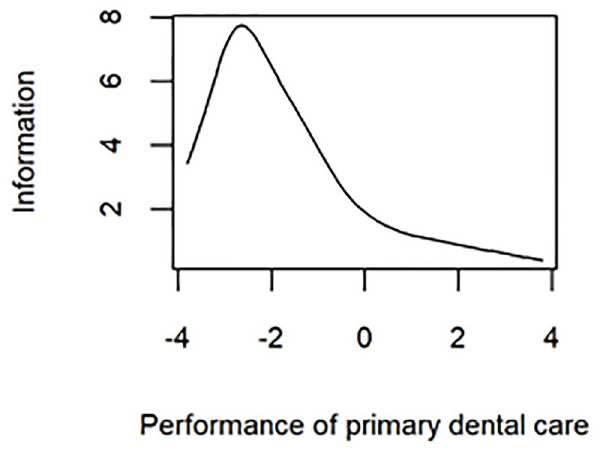
Fig 2. Test information curve, showing the score interval about which the present instrument provides more information.